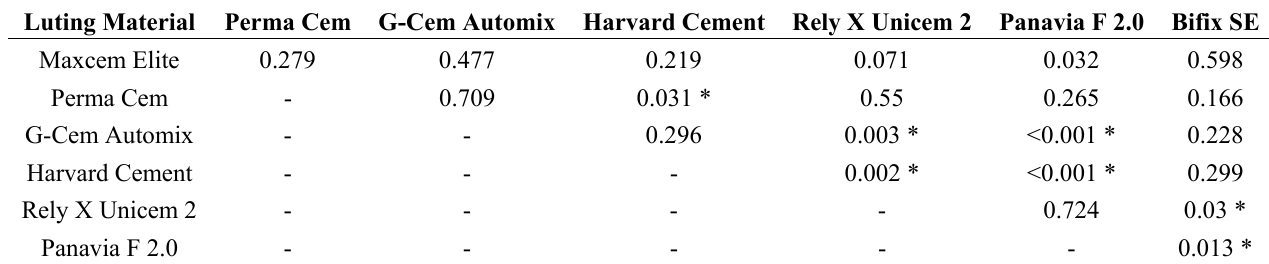
Table 3. P -values of the microleakage independent of the preparation location. Luting Material